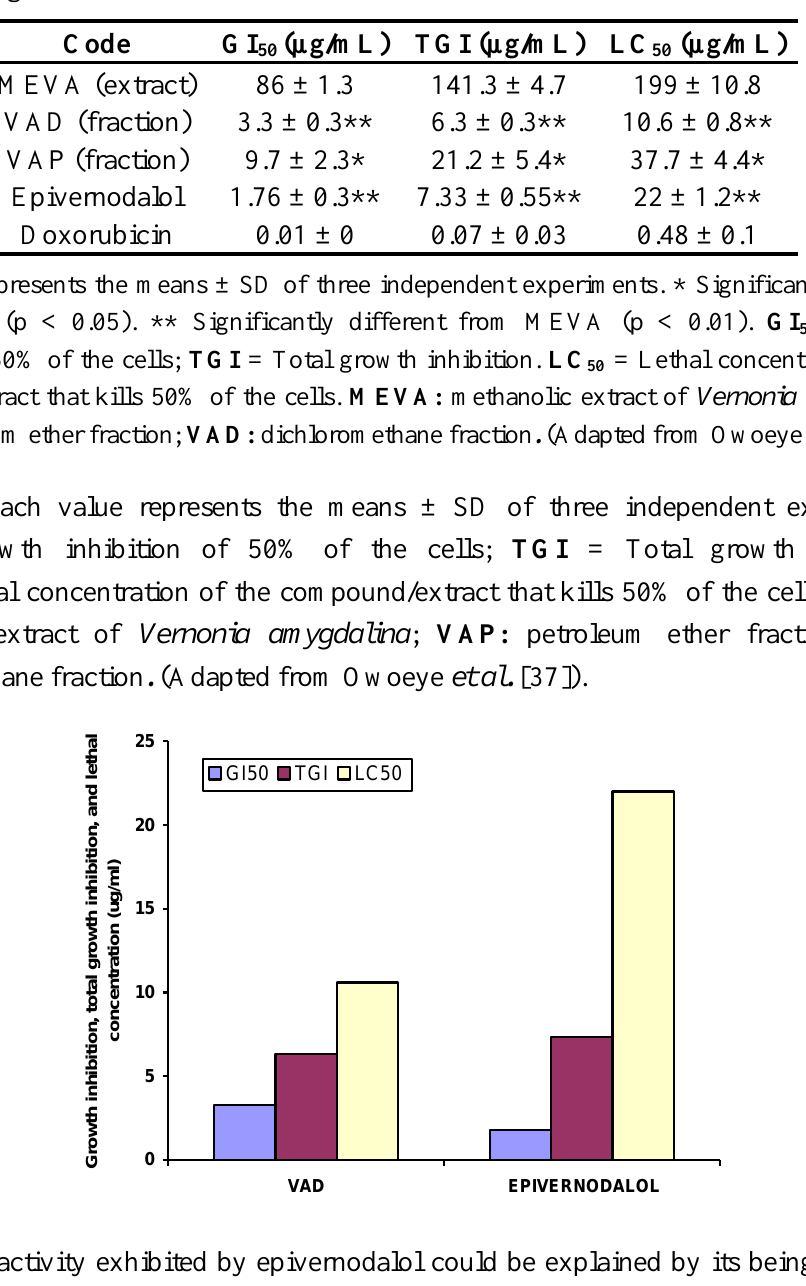
Table 2. Activity of Vernonia amygdalina Del. extract, fractions, Epivernodalol and doxorubicin against HT-144 (skin melanoma) cell line.